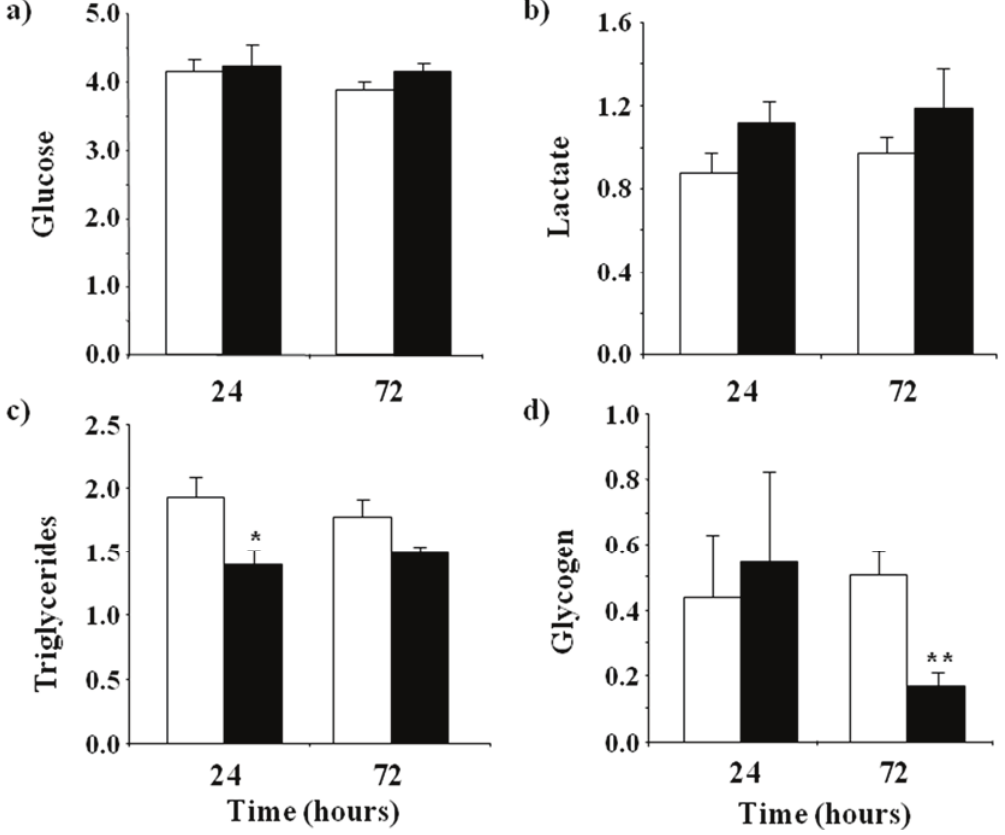
Figure 1. Changes in metabolite levels in plasma and fast skeletal muscle of trout at 24 or 72 h after saline (white bars) or lipopolysaccharide (black bars) injection. ( a ) Glucose; ( b ) lactate and ( c ) triglyceride concentrations in plasma are expressed as mM, where ( d ) glycogen levels in fast muscle are expressed in mg·g (cid:3)1 . Values shown are means ± SE of six fish per group, each analyzed in triplicate. Significant differences between control and treatment groups are shown with asterisks ( p <